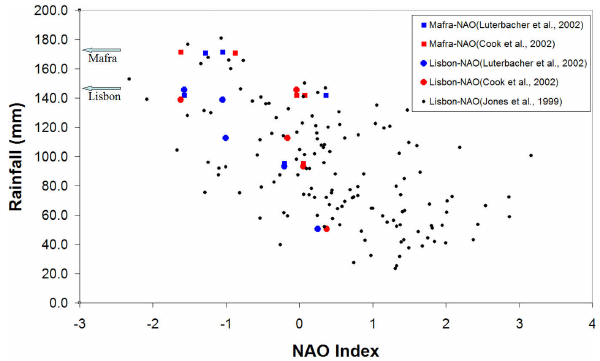
Figure 12. Relationship between the average precipitation for winter (DJFM) Fig. 12. Relationship between the average monthly precipitation for and the winter NAO index (DJFM). Arrows show the values for the 1783-1784 winter (see text for details). winter (DJFM) and the winter NAO index (DJFM). Arrows show the values for the 1783–1784 winter (see text for